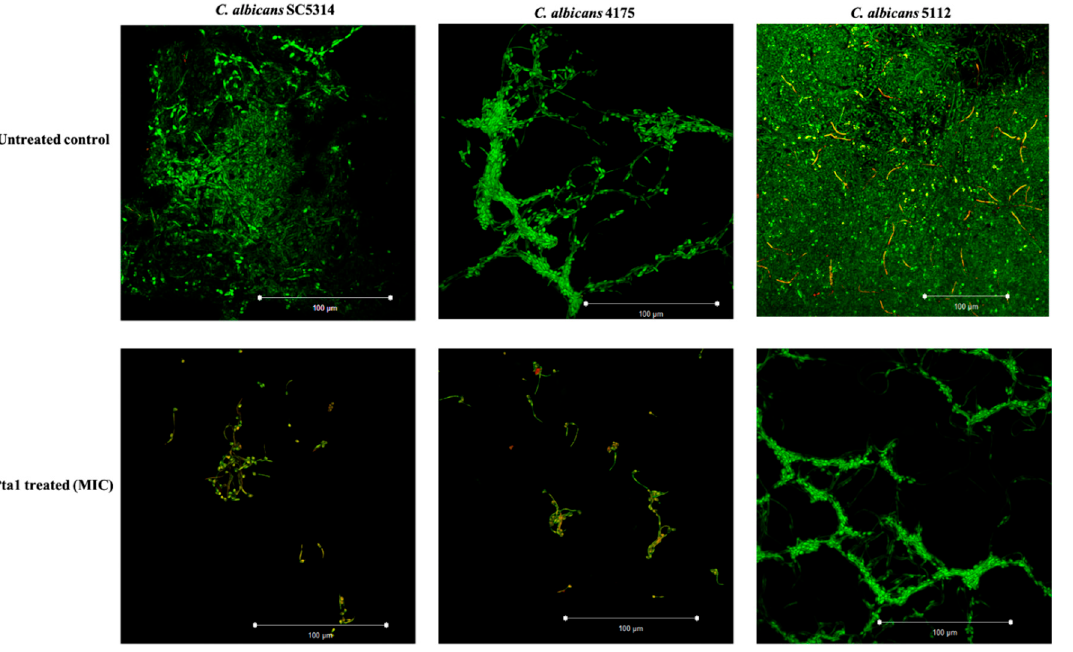
Figure 7. Anti-biofilm activity of piperidine derivatives. Representative figure of different C. albi- cans biofilms after exposure to pta-1, pta-2, and pta-3 at their inhibitory concentrations. The green fluoresces (Con A) represent the C. albicans cell wall as well as biofilm matrix; yellow-green fluo- resces (FUN-1) represent dead/metabolically inactive cells. 4. Conclusions This study reported the antifungal activity of triazole-based derivatives (pta1, pta2, and pta3) against fluconazole-susceptible and -resistant C. albicans strains. In-depth in silico and in vitro studies revealed that these compounds have the potential to interact with the LDM enzyme and downregulate the expression of ERG11 gene, which in turn inhibits the ergosterol biosynthesis pathway. This study builds on previous reports that these compounds induce apoptosis and cell cycle arrest, suggesting the potential to be developed as novel antifungal drugs with multiple mechanisms of action, thereby min-